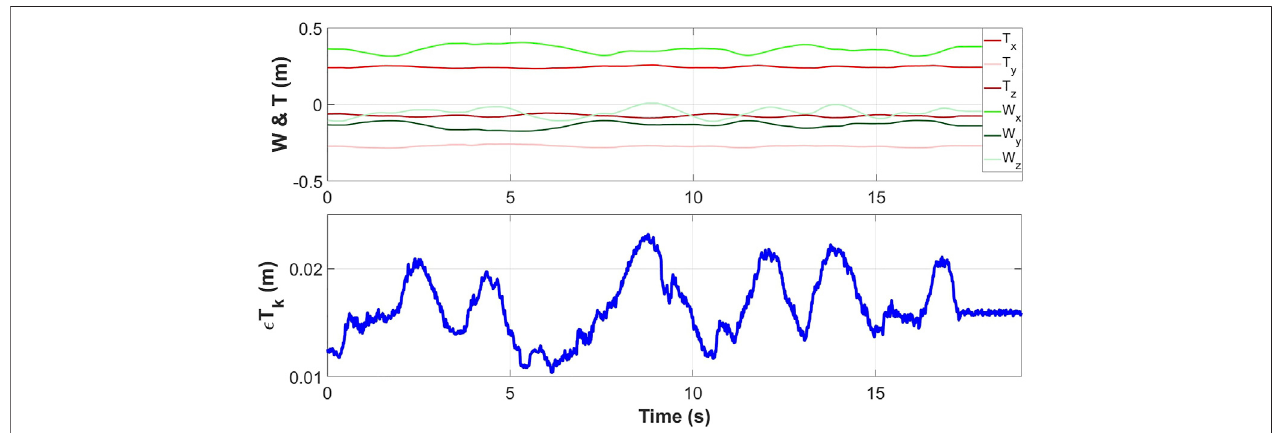
FIGURE8 | Measured positionof therobotwrist (green) and the instrumenttip (red) during adisplacement. Of fl ine reconstructed error ε T 2 ′ determined with the fi xed lever arm model.